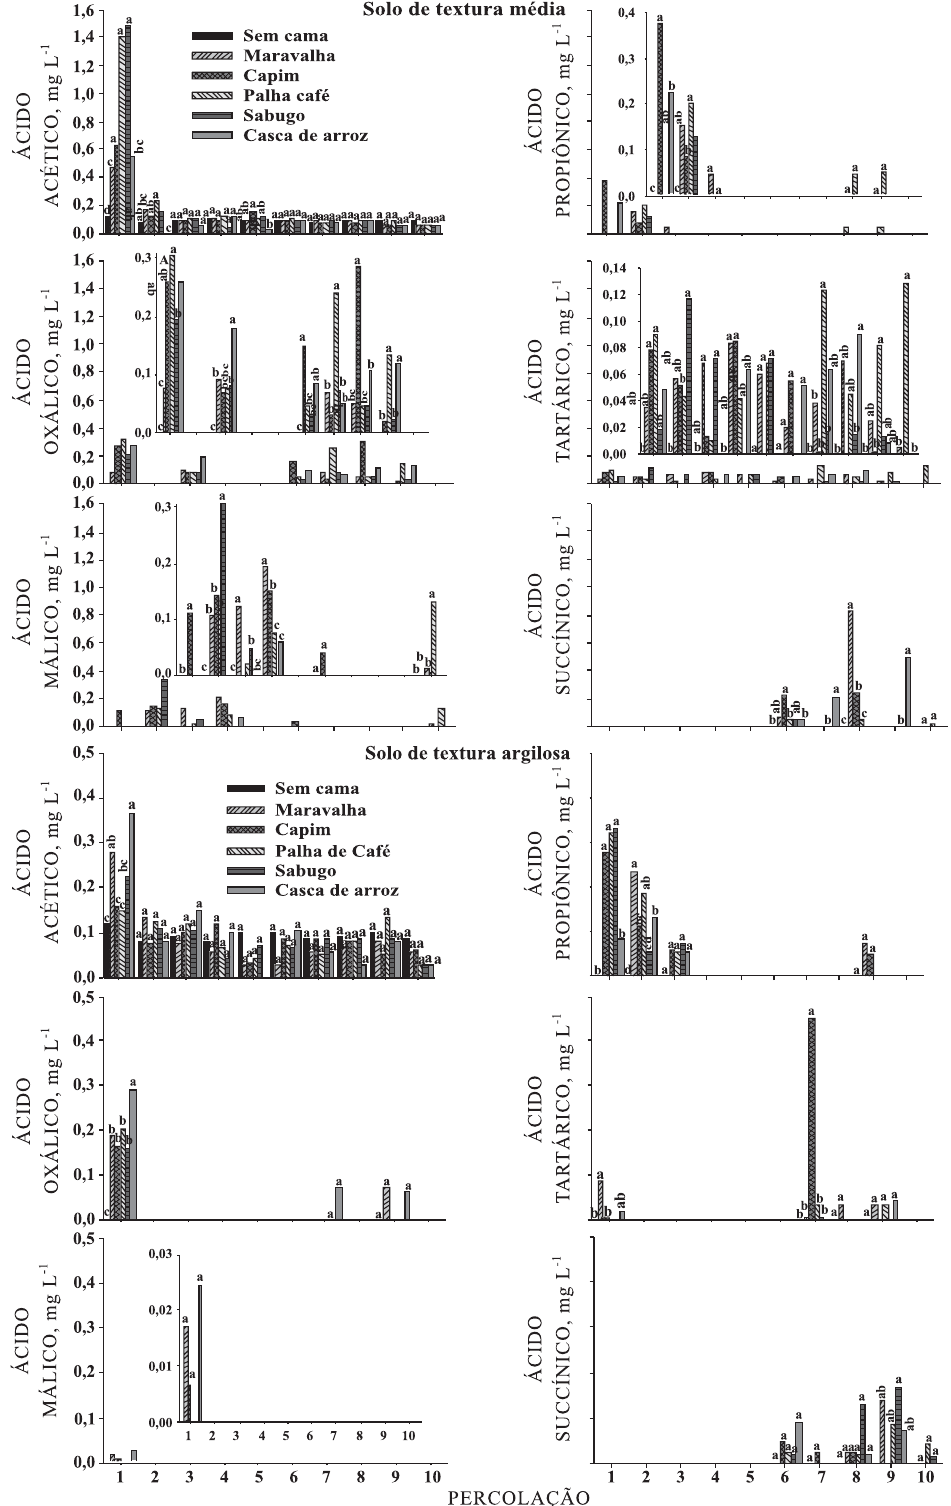
Figura 6. Concentração de ácidos orgânicos de baixa massa molecular em percolados coletados sucessivamente, ao longo do tempo, em Latossolos de textura média e argilosa, que receberam 160 t ha -1 , base material seco, de cinco tipos diferentes de cama de aviário, no anel superior de colunas de percolação, comparados à testemunha, sem cama de aviário. As médias das concentrações dos ácidos orgânicos seguidas pela mesma letra em uma mesma percolação, para as diferentes camas, não diferiram entre si pelo teste de Tukey, a 5